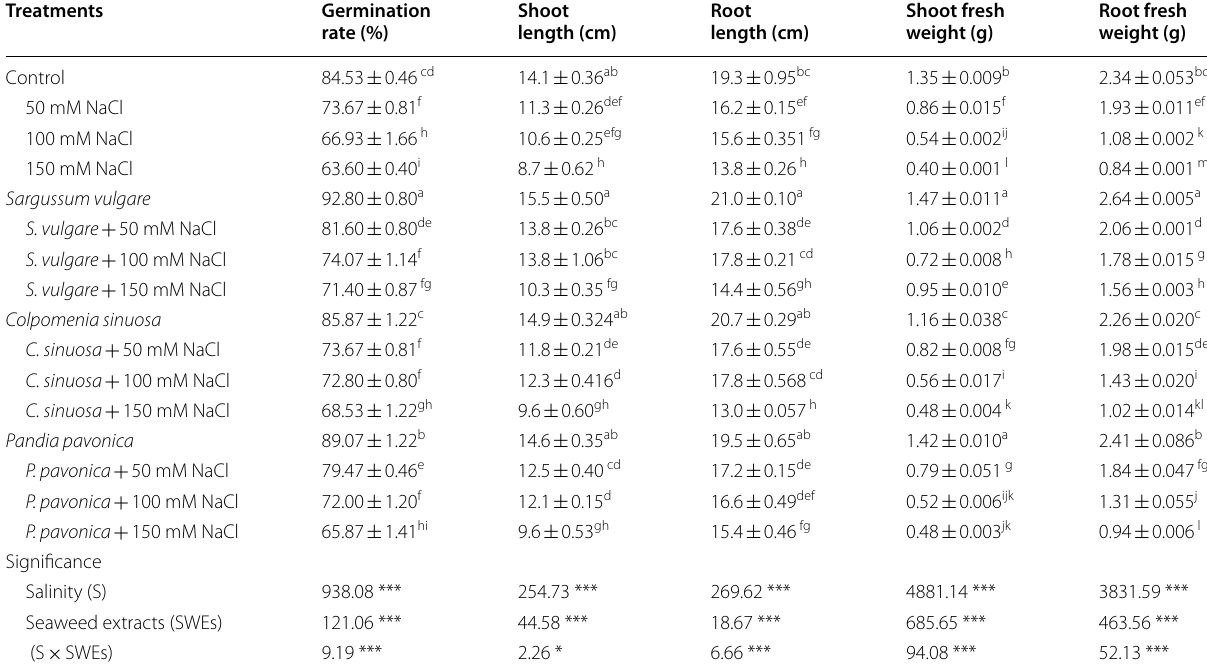
The values shown are average of three replicates Numbers represent the F value at 5% significance level